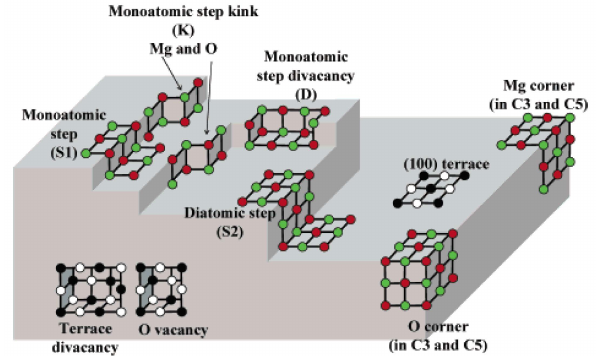
Figure 4. Schematical representation of MgO surface. Reproduced from [35] Copyright 2016,